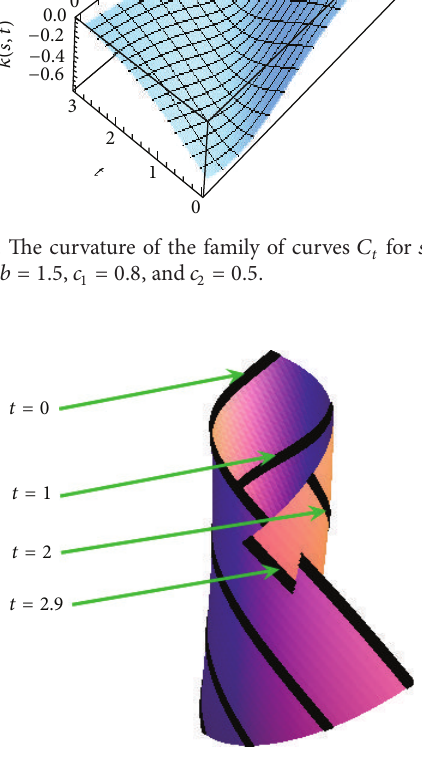
Figure 6: The surface that is generated by the motion of the family of curves 𝐶 𝑡 for 𝑠 ∈ [0, 8] , 𝑡 ∈ [0,3] , 𝑏 = 1.5 , 𝑐 1 = 0.8 , and 𝑐 2 = 0.5 . The bold black curves in this surface represent the family of curves 𝑡 = 0, 1, 2, 2.9 𝐶 𝑡 for